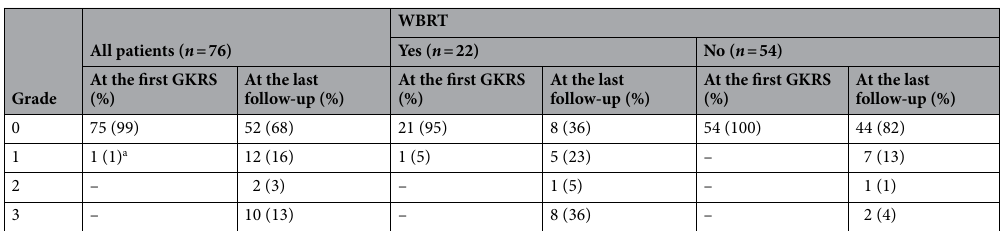
Table 5. Radiation-induced leukoencephalopathy. WBRT whole brain radiotherapy, GKRS gamma knife radiosurgery. a A grade 1 RIL was observed in one patient who underwent WBRT before the first